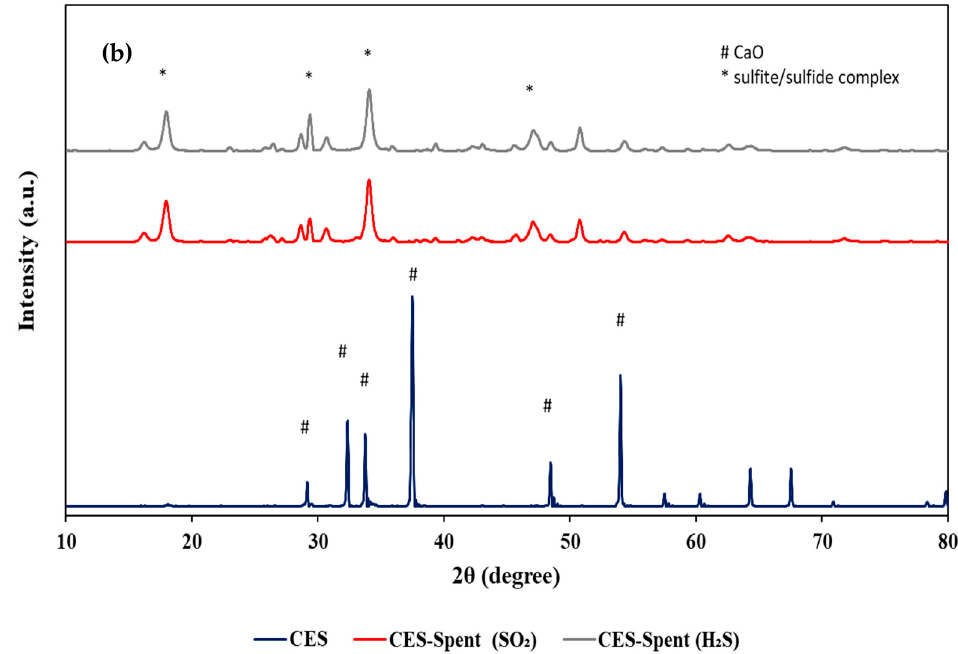
Figure 5. XRD pattern of ( a ) raw eggshell and ( b ) calcined eggshell (900 °C) before and after adsorption.